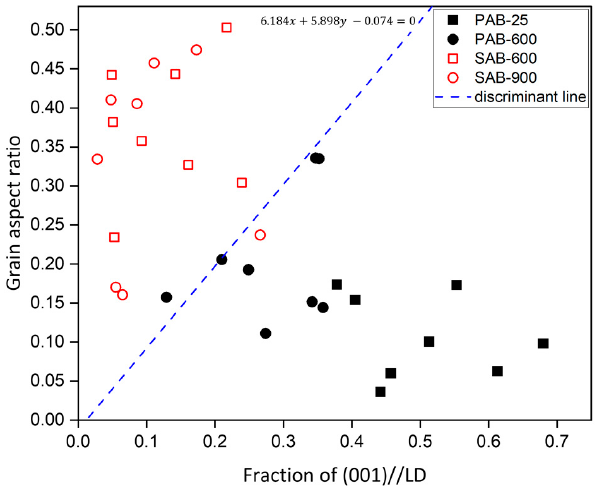
Figure 4. Data distribution according to the grain aspect ratio (GAR) and fraction of (001) perpendicular to demarcation line (//LD) in primary-arc beads (PABs) and secondary-arc beads (SABs).